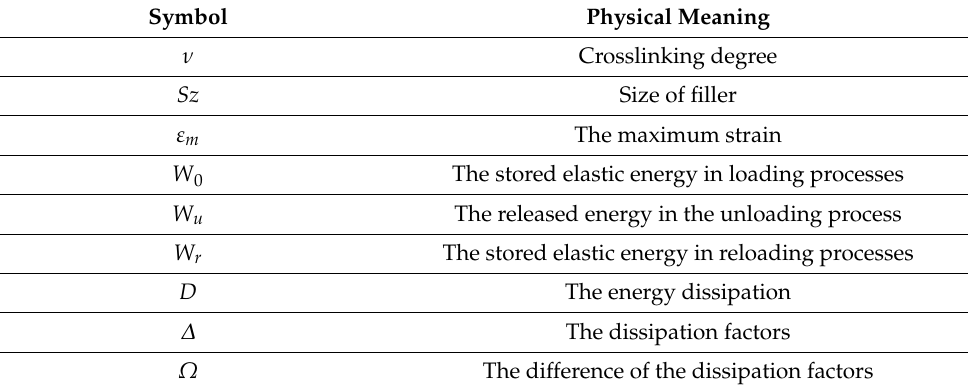
Table A1. The list of